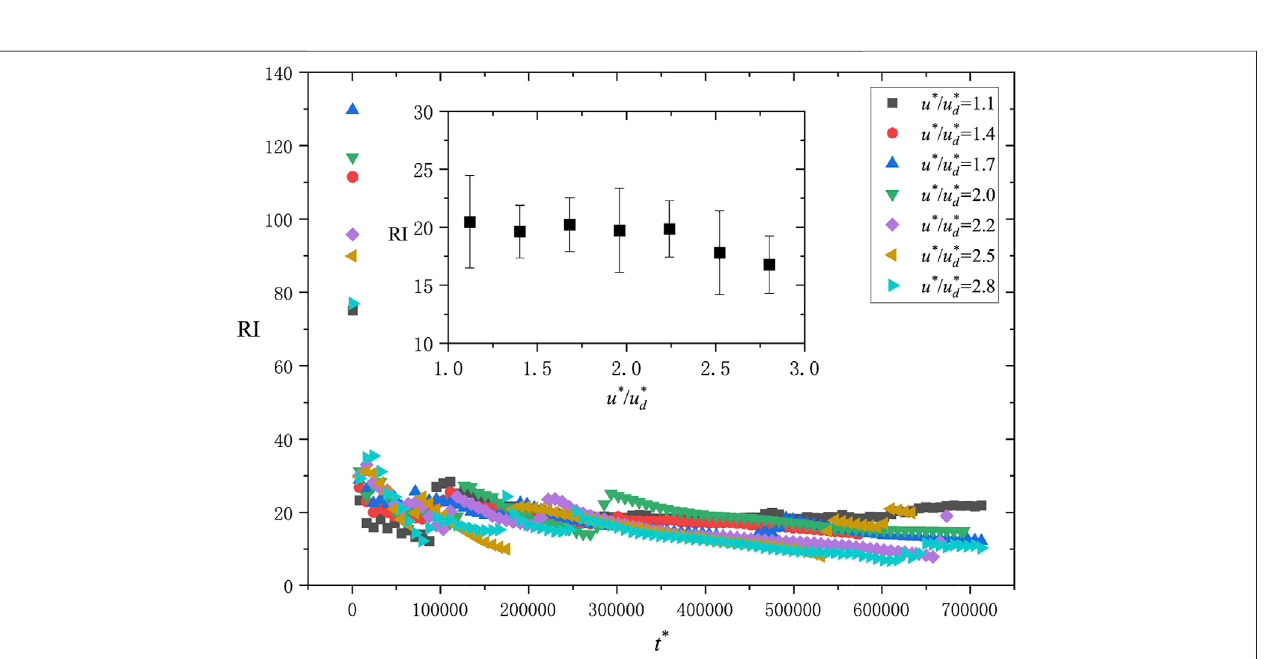
Frontiers in Physics |